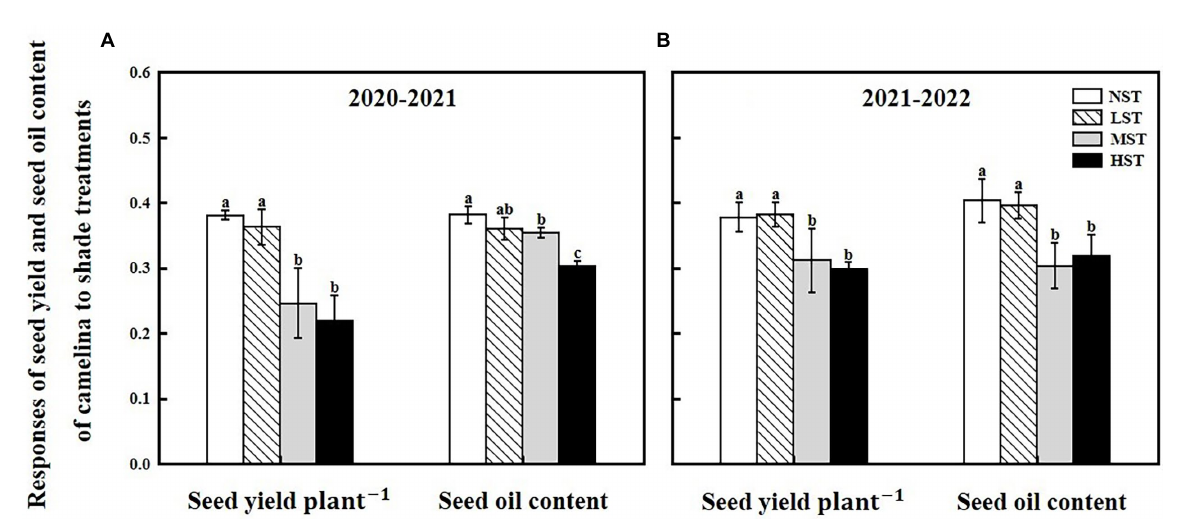
FIGURE 3 Responses of seed yield plant − 1 (g) and seed oil content (%) of camelina across the 16 genotypes to three different artificial shade levels (15%-LST, 25%-MST, and 50%-HST reduction in natural light intensity, respectively) in 2020–2021 (A) and 2021–2022 (B) . Individual values are means of each parameter measured across the 16 camelina genotypes ± stand errors. Different letters represent the significant different values by Tukey post-hoc test ( p ≤